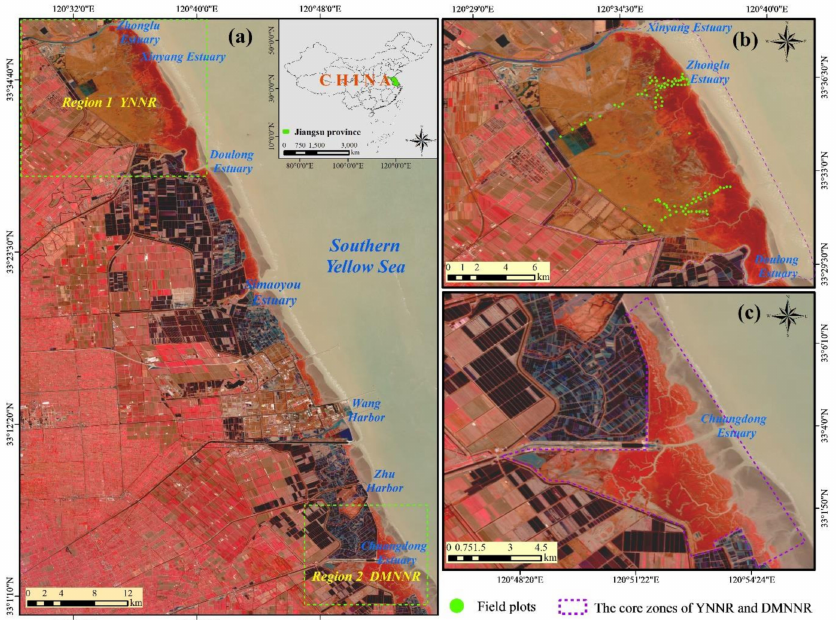
Figure 1. Location of the study area. ( a ) Overview of the study area in the Gaofen-1 wide-field-of-view (GF-1 WFV) RGB composite (R: 4 G: 3. B: 2) image on 16 December 2015. ( b ) Location of the Yancheng National Natural Reserve (YNNR) with field plots and ( c ) location of the Dafeng Milu National Nature Reserve